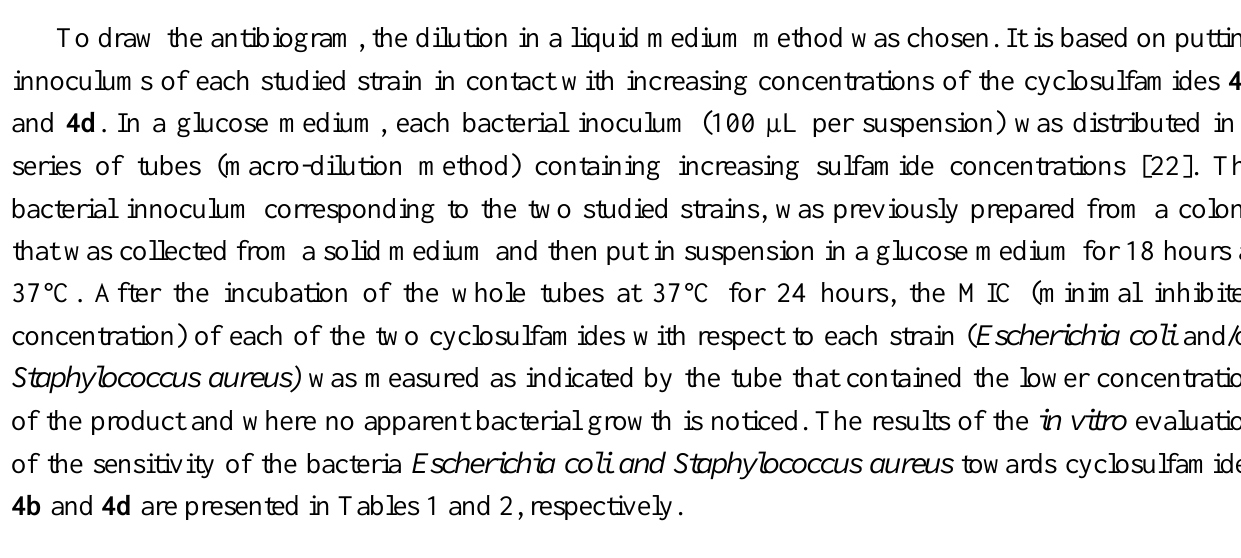
Table 1. Strain sensitivity towards cyclosulfamide 4b